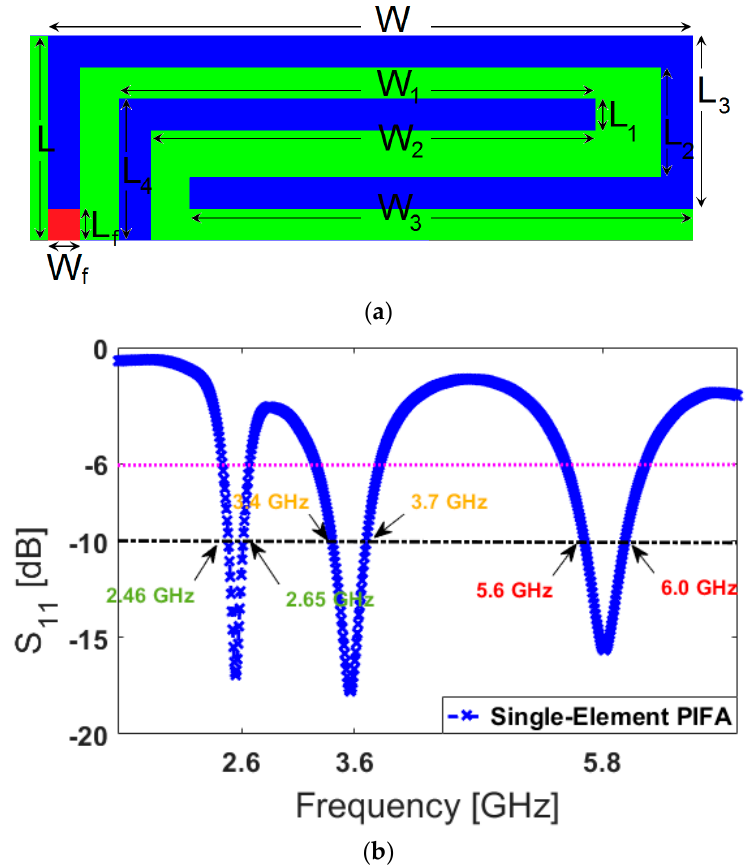
Figure 2. ( a ) Transparent view of the planar-inverted F antenna (PIFA) and ( b ) its S 11 performance.